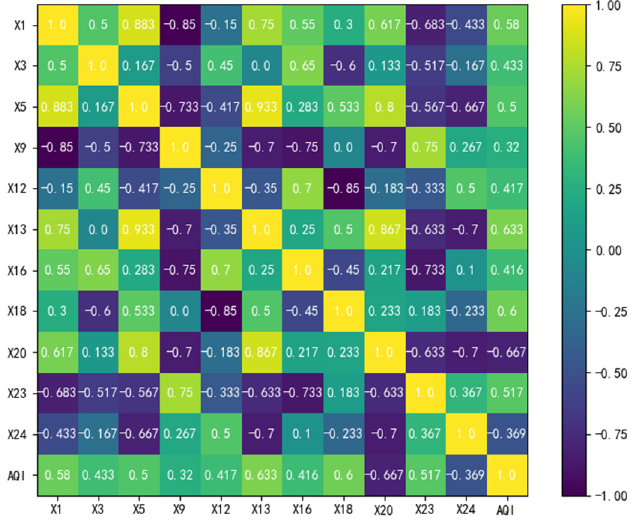
Figure 4. The SC correlation analysis results of APIIU of AQI.